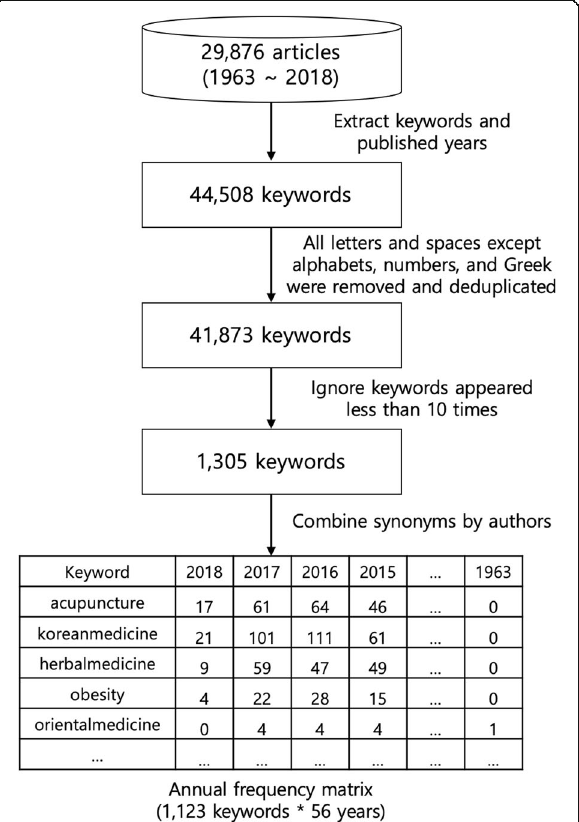
Fig. 1 Process for constructing the annual frequency matrix of the keywords. A matrix consisting of 1123 keywords over 56 years was constructed from 29,876